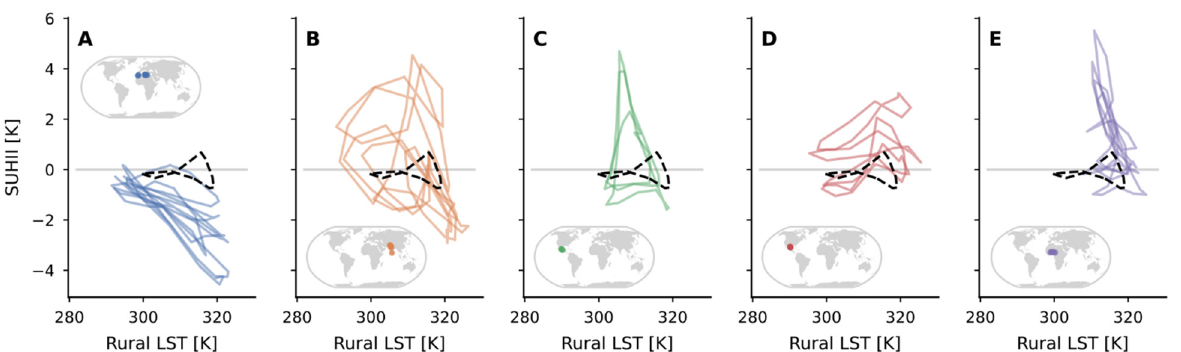
Figure 4. The individual daytime SUHII hysteresis loops for hot semi-arid (BSh) cities in North Af- rica ( A ), South Asia ( B ), Central America—Mexico ( C ), Central America—USA ( D ), and West Africa ( E ). The dashed line is the mean BSh loop from Figure 3.